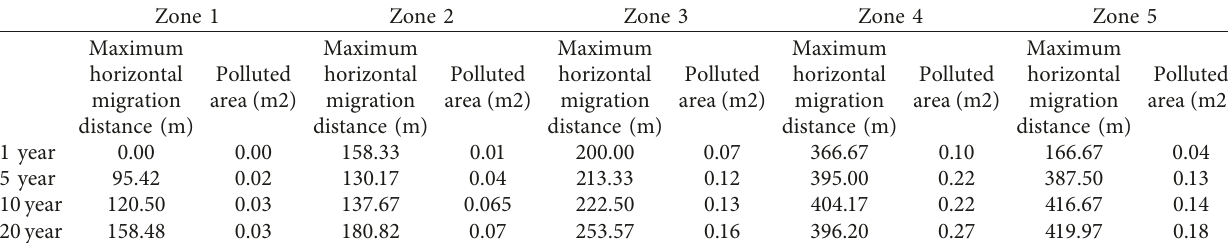
Figure 9: Total chromium pollution plume profile in the study area. Table 3: Prediction results of total chromium pollution plume in